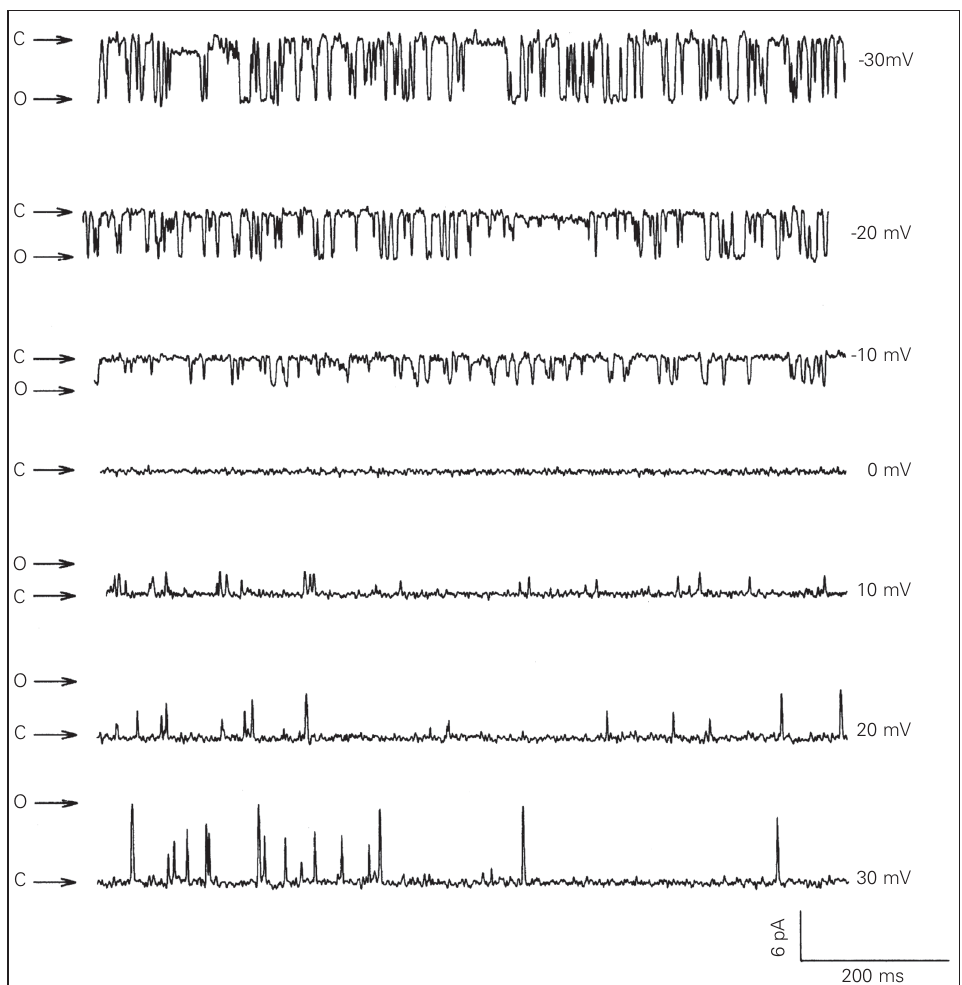
Figure 1. Typical example of the channel activity formed by toxin(s) from skin secretion of Siphonops paulensis incorpo- rated into the lipid bilayer. The channel clearly shows voltage dependence. In C , the channel is in the closed state, and in O the channel is